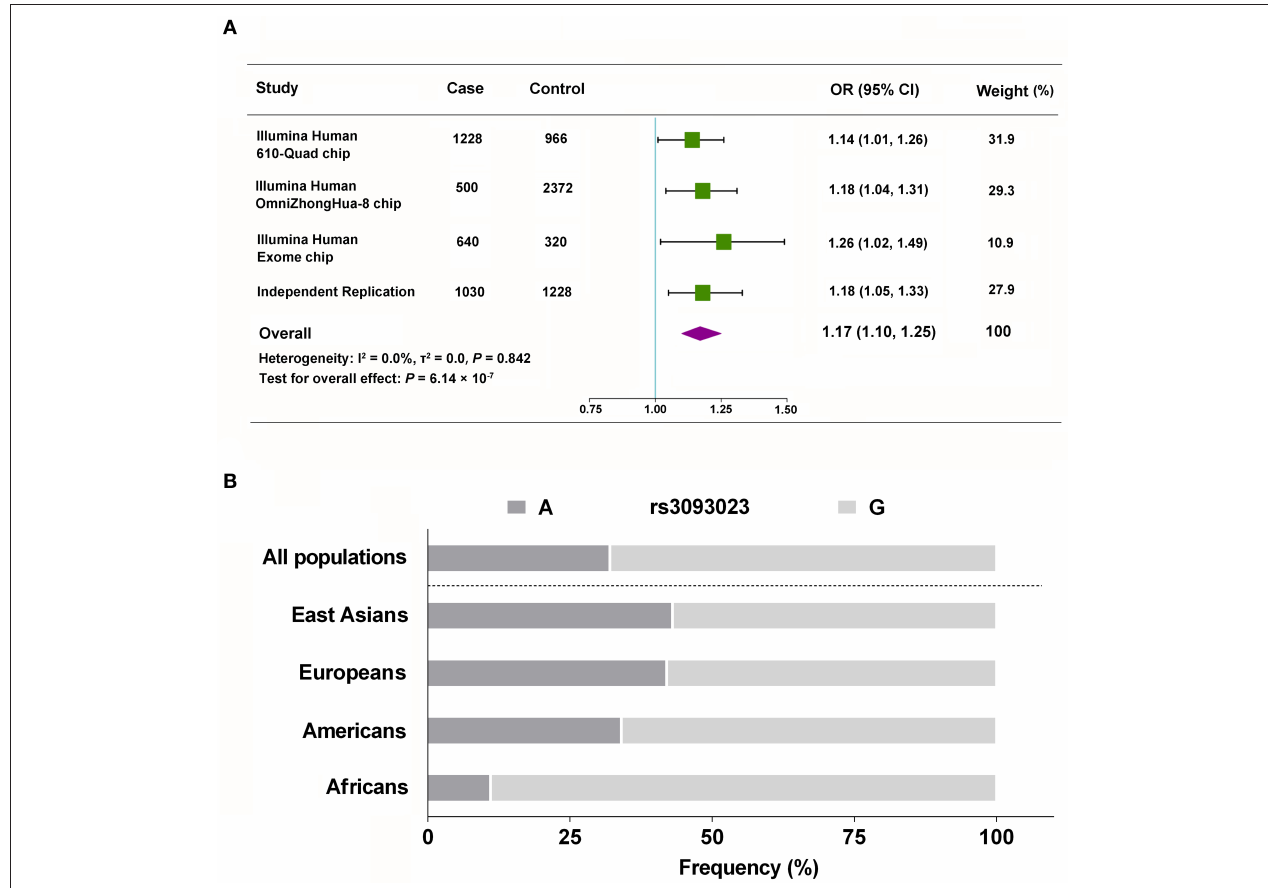
FIGURE 2 | Meta-analysis of rs3093023. (A) The combined analysis with the discovery and replication cohorts. (B) Racial distribution of the rs3093023 alleles. OR, odds ratio; 95% CI, 95% confidence interval.